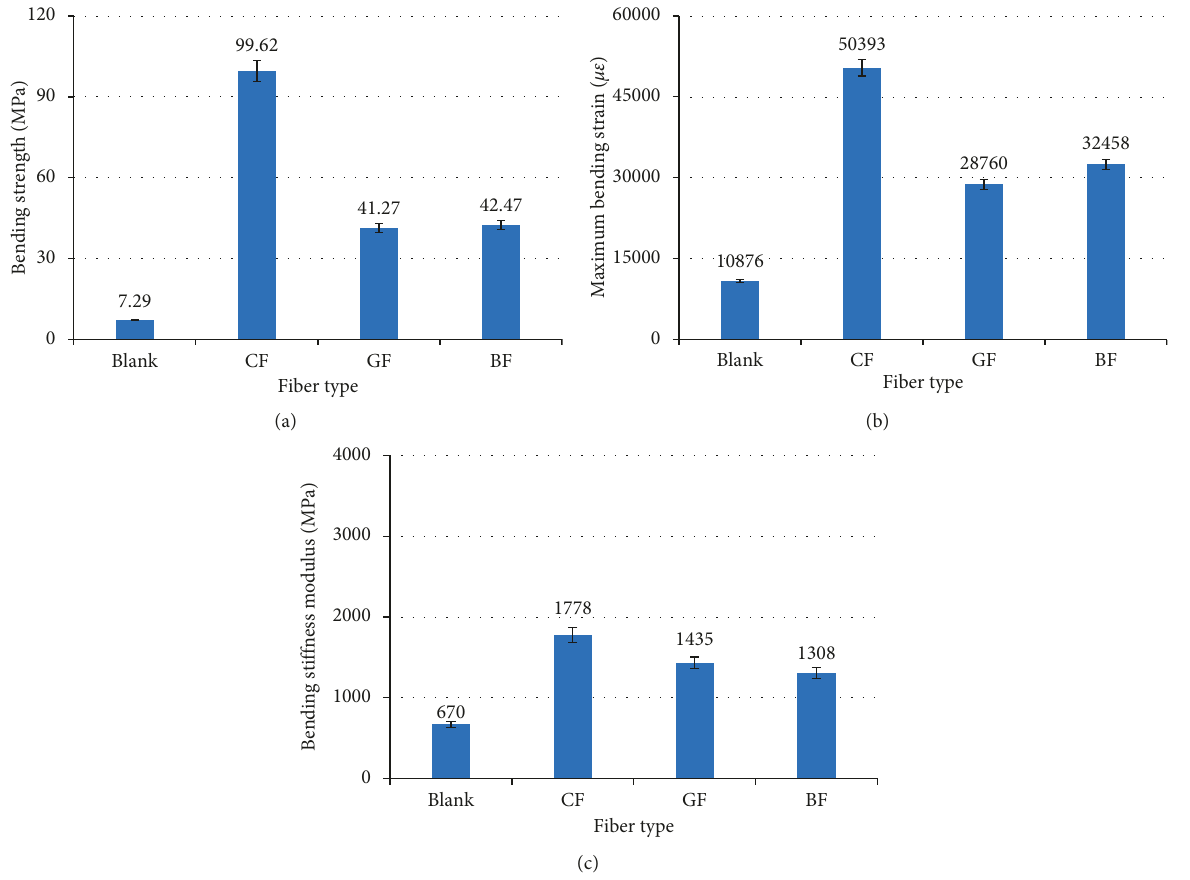
Figure 12: Bending test results at room temperature: (a) bending strength at 15 ° C; (b) the maximum bending strain at 15 ° C; (c) bending stiffness modulus in failure at 15 ° C.